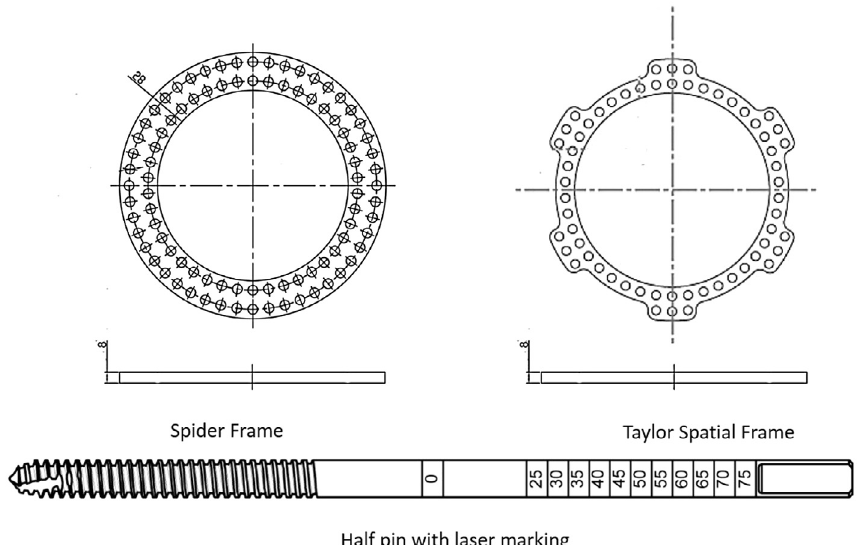
Figure 8. Spider Frame half pins are laser marked with a depth scale, enabling the surgeon to determine the depth to which the half pin is implanted by checking its scale. The rings in the Spider Frame range from 100 mm to 300 mm. Unlike predicate devices, the Spider Frame ring has double-sided holes on its